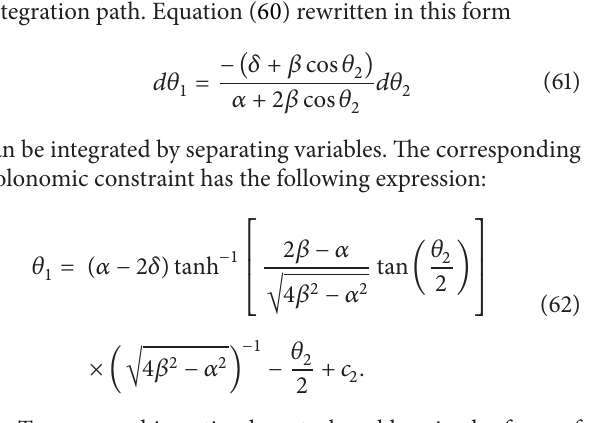
̇𝜃 (𝑡 ) = 0 [ rad / s ] , ̇𝜃 (𝑡 ) = 0 [ rad / s ] , 𝜃 1 𝐼 2 𝐼 = 0 and 𝑡 = 1 [ s ] , respectively. The corresponding sequence of configurations of the 𝐼 𝐹